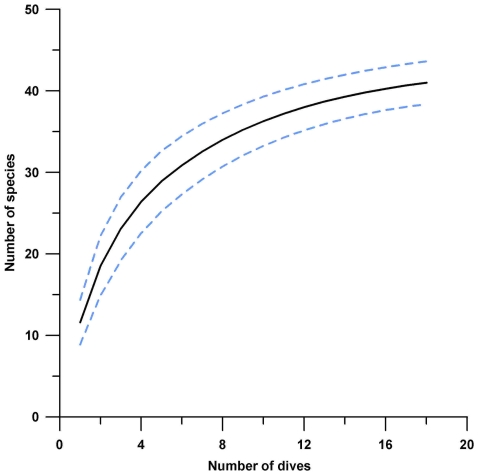
Expected species accumulation curve for stony corals on Saba Bank.The graph shows Mao Tau (Sobs) values (black solid line) with 95% confidence intervals (dashed light blue lines) based on incidence data from 18 dives. The curve appears to be approaching asymptote, indicating the most common species were collected. More species of coral are likely to be found, through more exhaustive sampling effort and deeper exploration of Saba Bank.